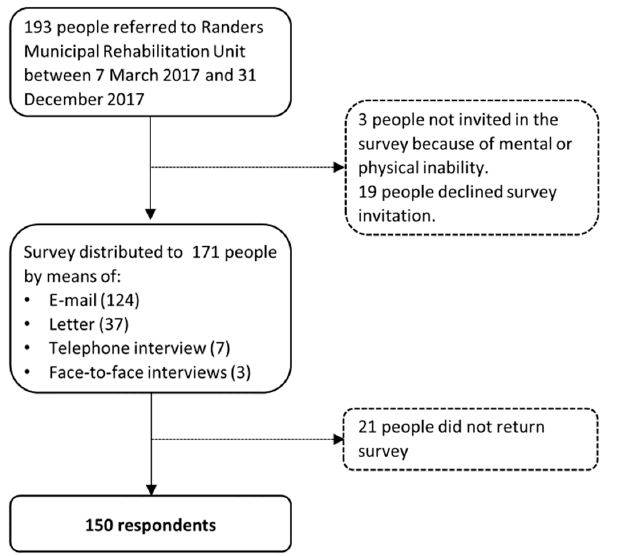
Figure 1. The recruitment of survey respondents for the Heart Skills Survey in Randers Municipal Rehabilitation Unit, 2017.